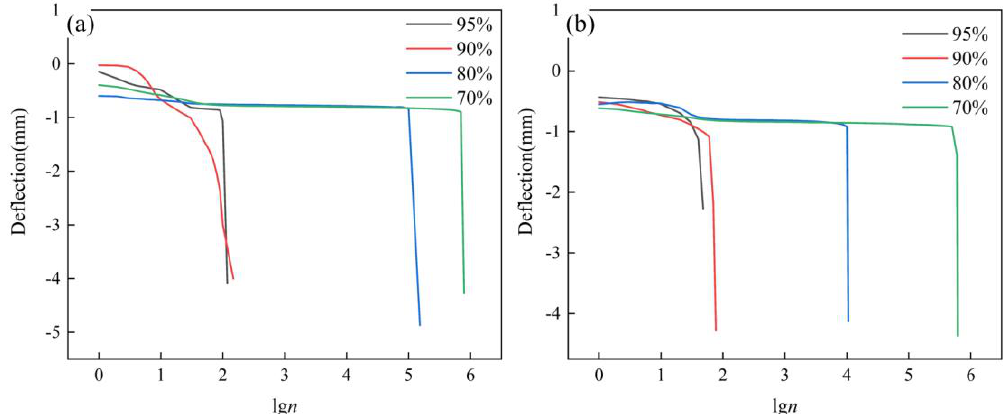
Figure 7. Deflection life curves at different load levels. ( a ) AFS prepared by the powder metallurgy method, ( b ) AFS prepared by the adhesive method.